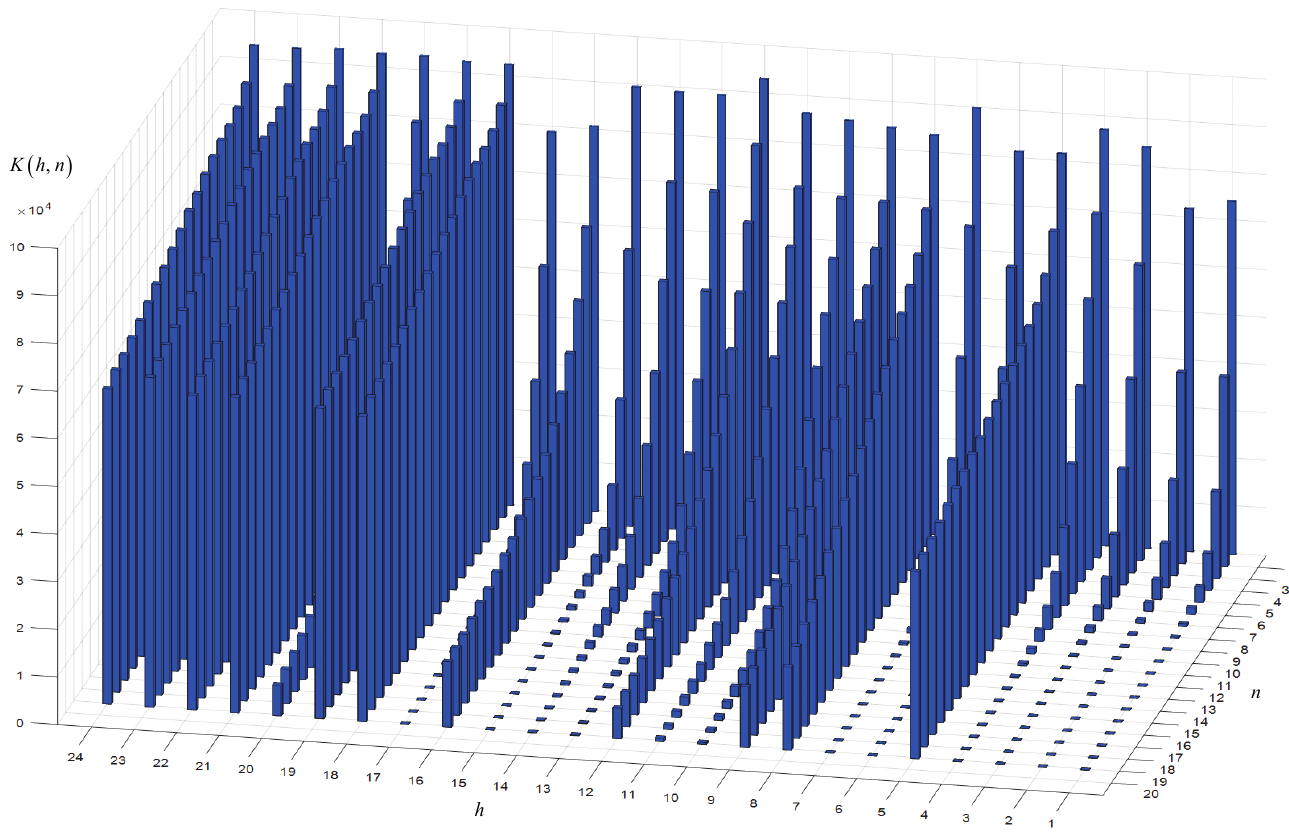
Fig. 5. Distribution of number K ( h , n ) per 100 000 instances for the case with (24).